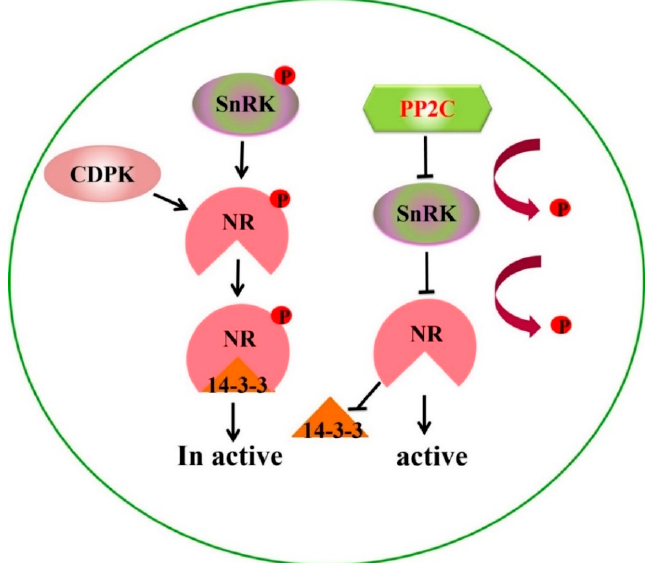
Figure 7. Potential molecular pathway based on differentially expressed proteins in PP2C9TL under N deficient conditions. The red color text shows the upregulation and green color text shows downregulation of proteins. Note RUBP (Ribulose 1, 5-bisphosphate), RuBisCO (Ribulose-1,5- bisphosphate carboxylase/oxygenase), 1,3 BPG (1,3-Bisphosphoglycerate), FBA (Fructose-bisphosphate aldolase), F6P (Fructose-bisphosphate aldolase), SBP (sedoheptulose-1,7-bisphosphatase), PSII (Photosystem II), OOEs (oxygen evolving enhancer proteins), PSI (Photosystem I), GLS (Glutaminase), and GS (Glutamate synthase).